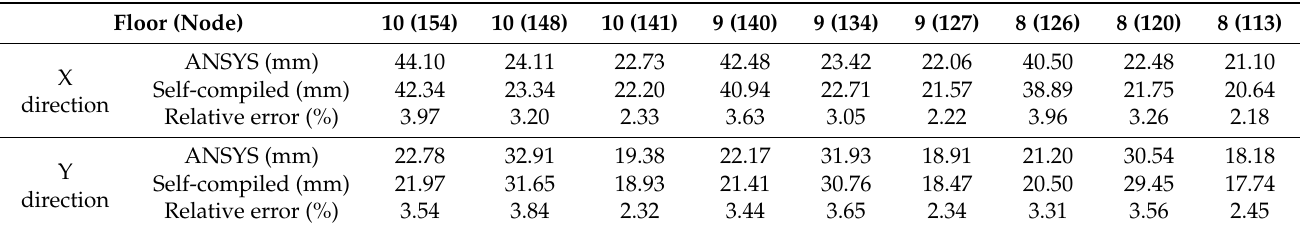
Table 3. Contrasts of the maximum displacement of the nodes between the self-compiled program and the ANSYS model.